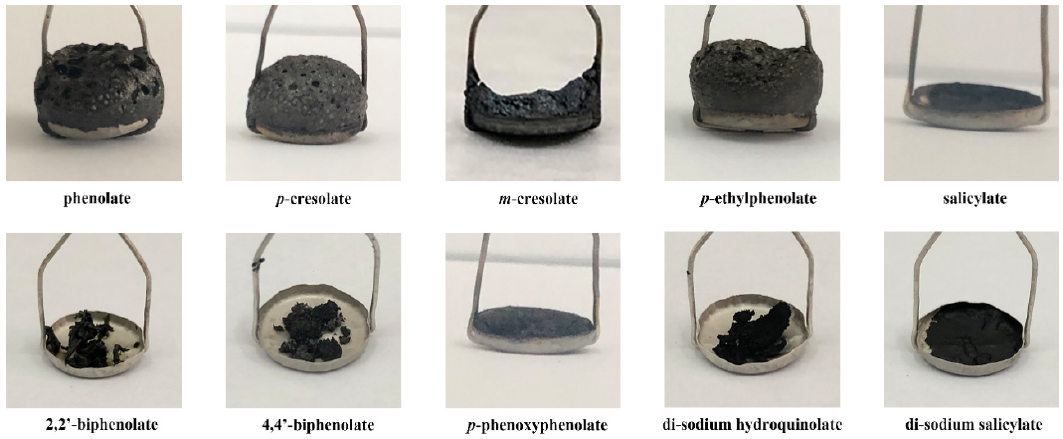
Figure 7. Images of char residues of sodium phenolates collected at 600 °C.